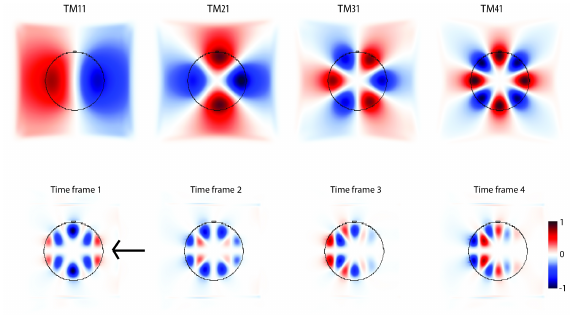
Figure 1: (Top) Resonant modes in an infinitely long cylinder of GaAs with diameter of 220 nm with light incident parallel to NW axis. (Bottom) The Poynting vector at different time frames with light incident perpendicular to the NW axis from the